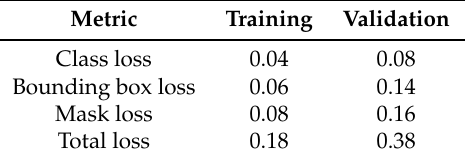
Table 4. Metrics values obtained by Mask R-CNN training and validation after 120 epochs.